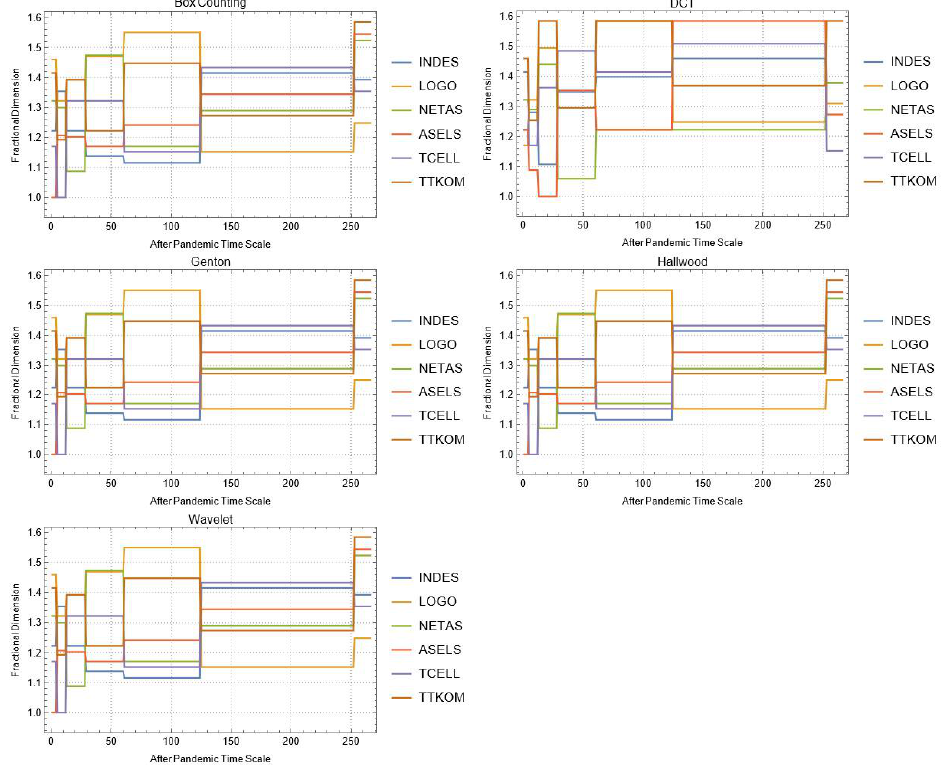
Figure A26. Daily changes of fractal dimensions after the pandemic (technology).